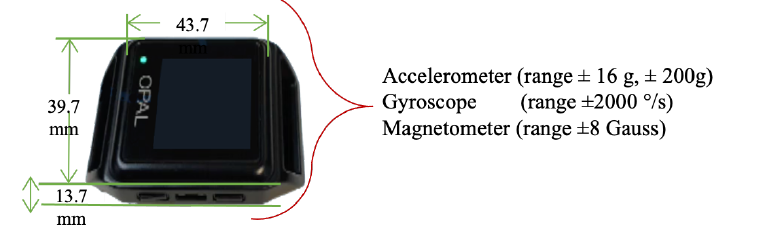
Figure 7. APDM Opal V2 IMU.